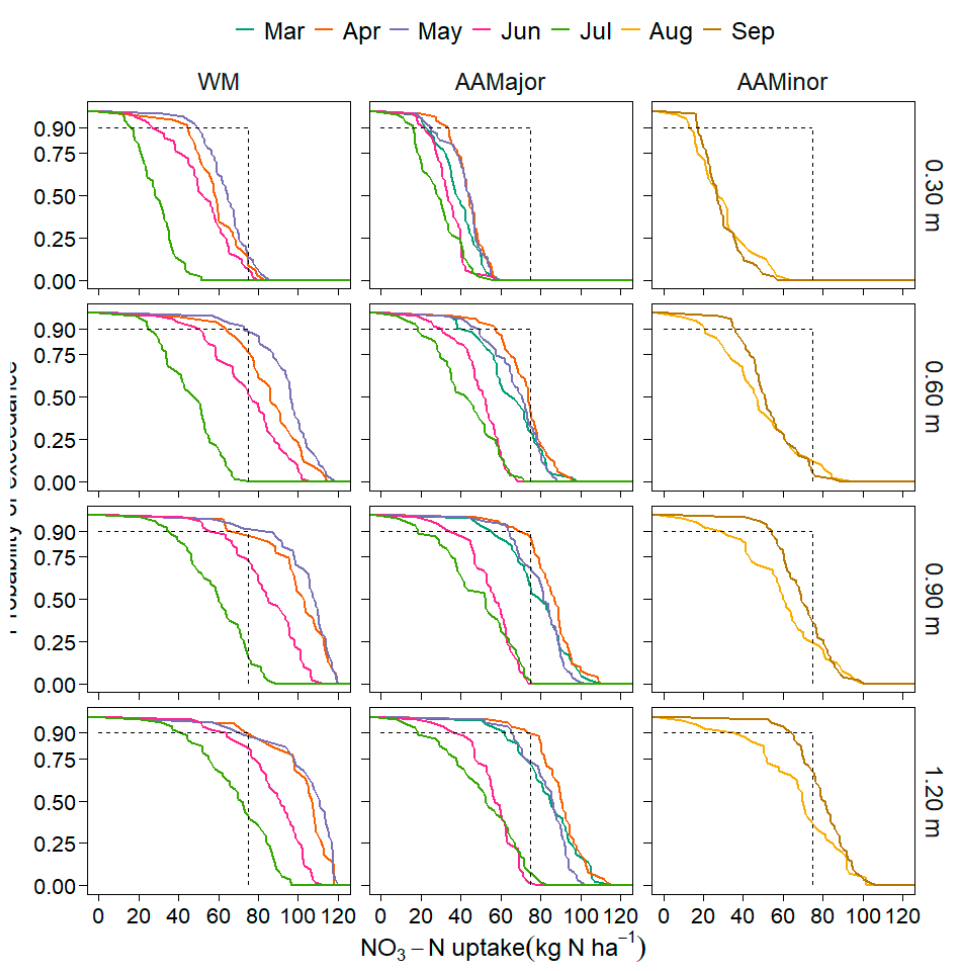
Figure 12. Simulated NO 3 -N uptake for di ff erent maize rooting depth in treatment receiving 75 kg N ha − 1 and for various sowing months. The vertical broken line denotes NO 3 -N uptake and the horizontal broken line represents the 90% probability that crop uptake will be equaled or